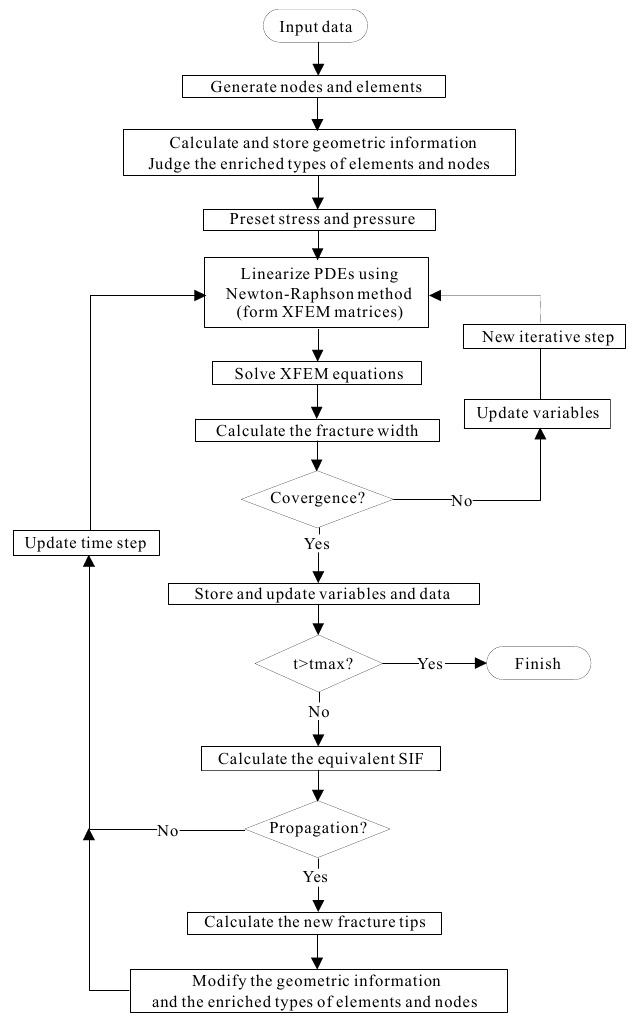
Figure 4. UXFEM flow chart.